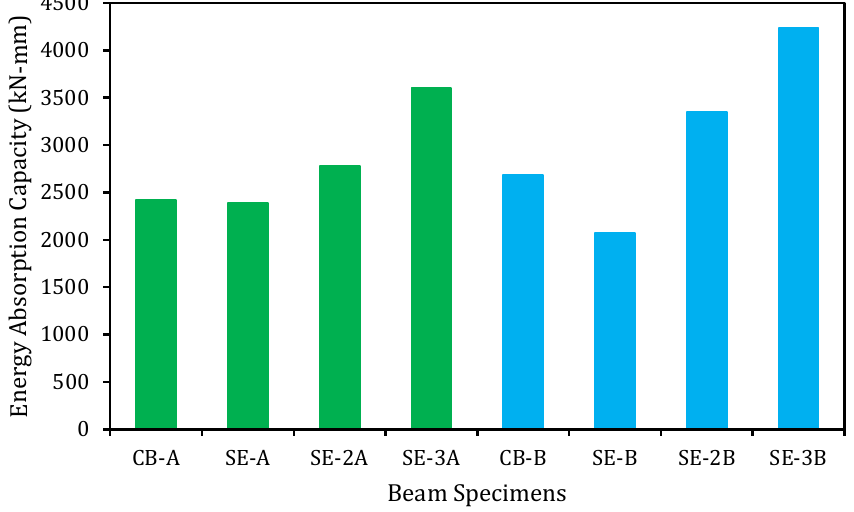
Figure 10. Energy absorption capacity of side-EBR strengthened beams.